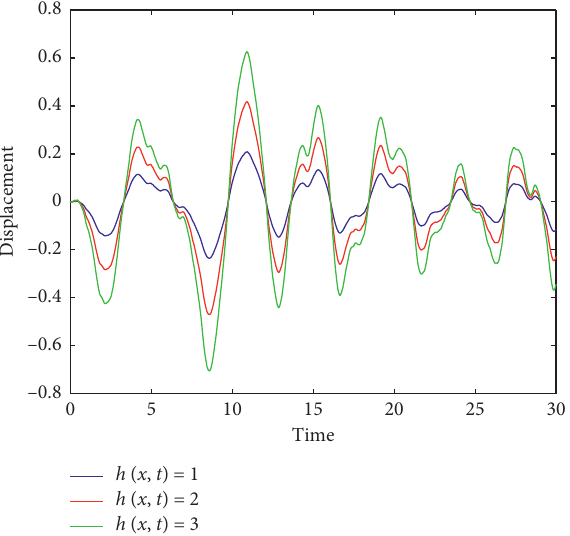
Figure 7: Vibrational behavior of 11 th story in the passive mode and for different magnitudes of h ( x, t )